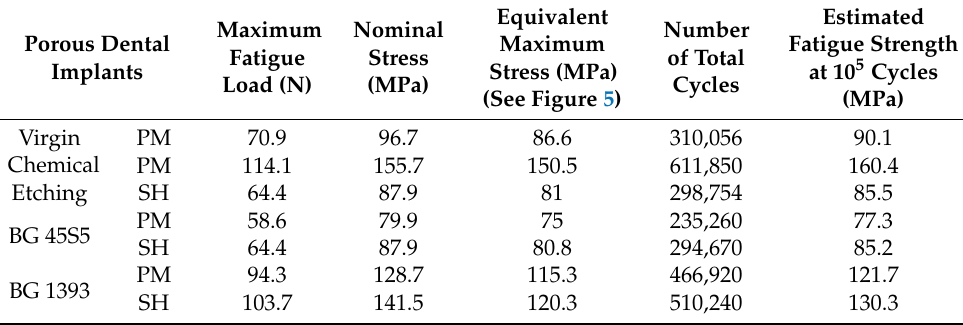
Table 3. Step fatigue tests of porous dental implants (PM and SH 30